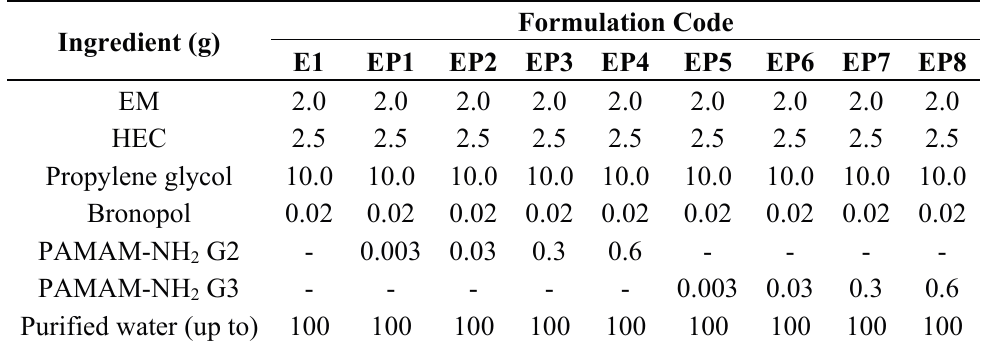
Table 1. Composition of prepared